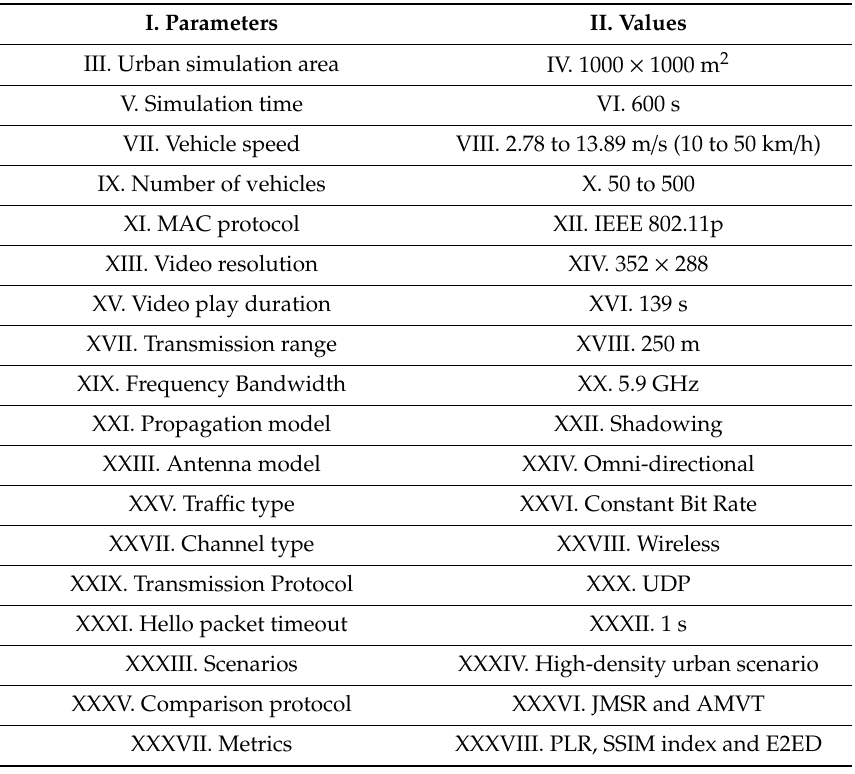
Table 1. Simulation parameters. JMSR: Junction-Based Multipath Source Routing; AMVT: Adaptive Multipath geographic routing for Video Transmission; PLR: Packet Loss Rate; SSIM: Structural Similarity Index; E2ED: End-to-End